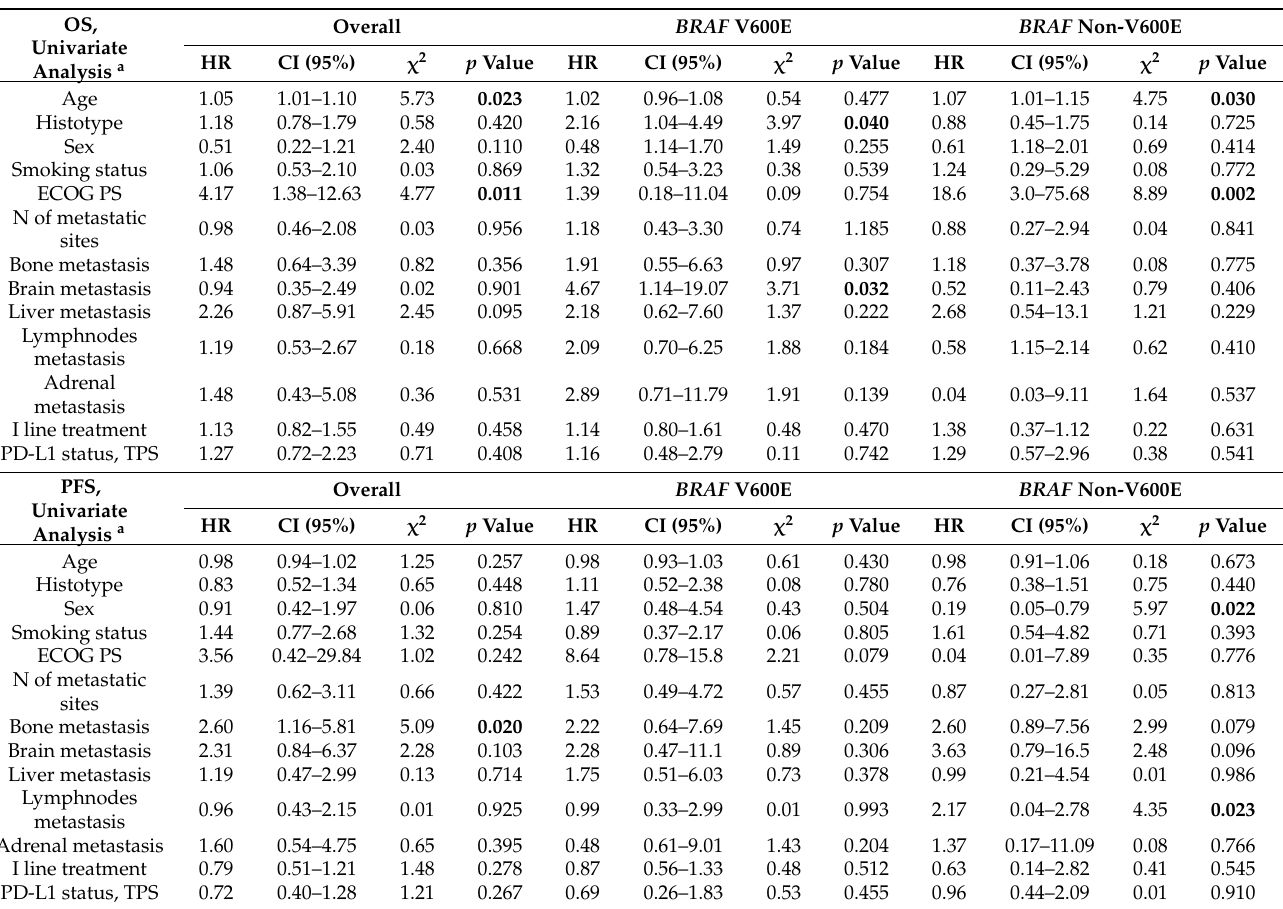
Table 2. Explanatory prognostic factors in Cox proportional hazard models: uni- and multivariate analysis illustrating the impact on OS and PFS of clinico-pathological